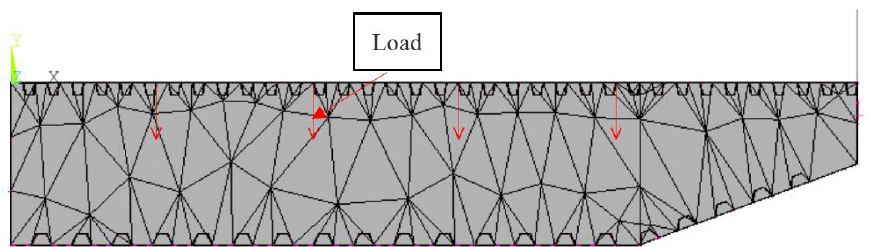
Figure 2. Cross section of box girder of the numerical simulation and calculation model in Nansha Bridge Dasha Waterway Bridge.